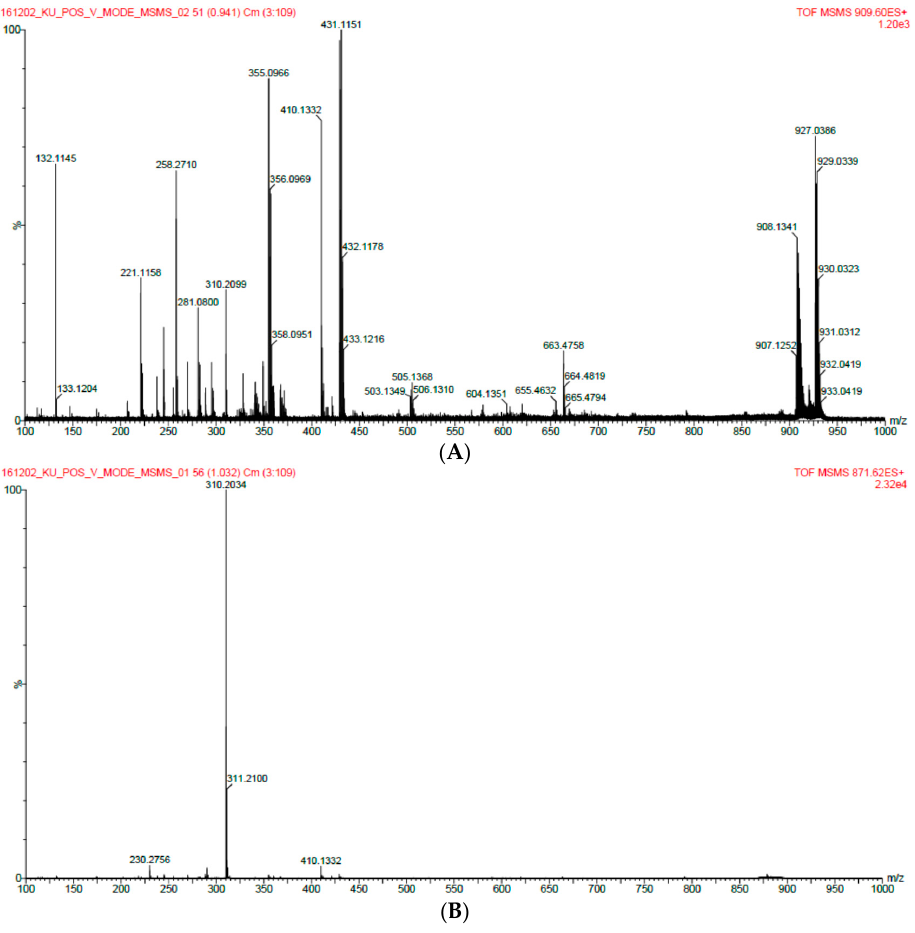
Figure 13. ESI-MS analysis of 871 m / z material. ( A ) m / z 871 peak of the LC/MS analysis results; ( B ) m / z 927 peak of the ESI-MS analysis results.